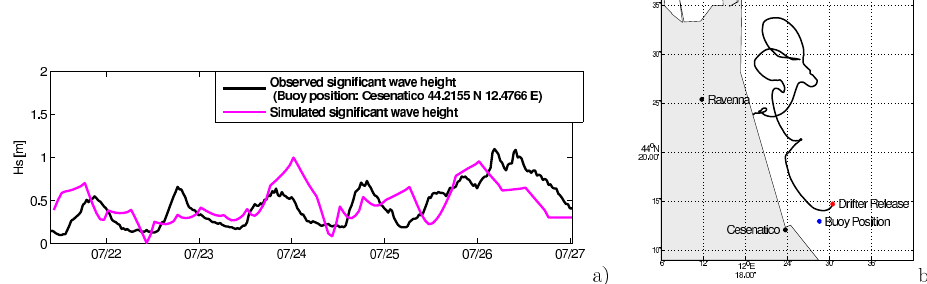
Fig. 9. (a) MEDSLIK-II simulated significant wave height (pink line) compared with the significant wave height measured by the wave buoy off Cesenatico (black line); (b) map of the region; the black line is the drifter trajectory also shown in Fig. 7.